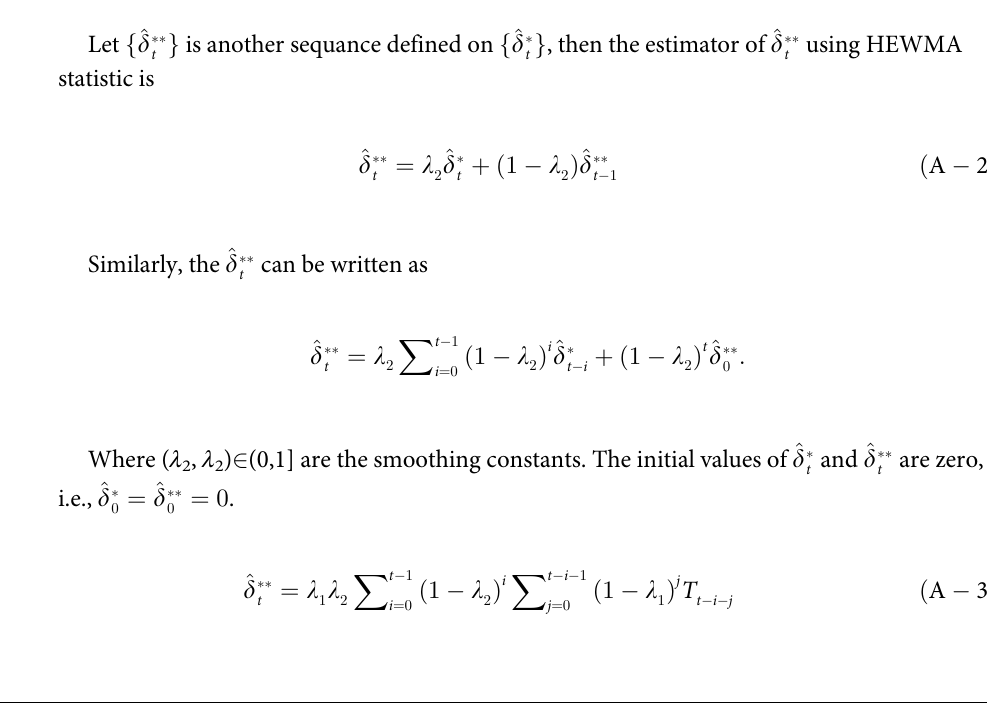
Fig 6. AEWMA AIB chart with real-life data of ground water using ρ = 0.50, λ = 0.2, h =